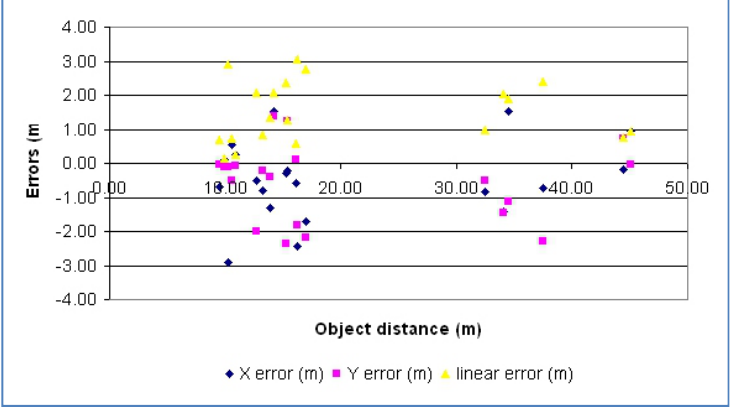
Figure 12. Errors in measured absolute coordinates with distances to objects in meters.